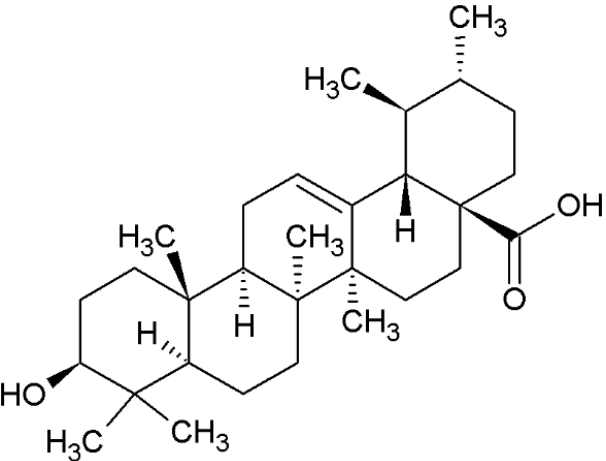
Figure 1. Chemical structure of ursolic acid (UA).